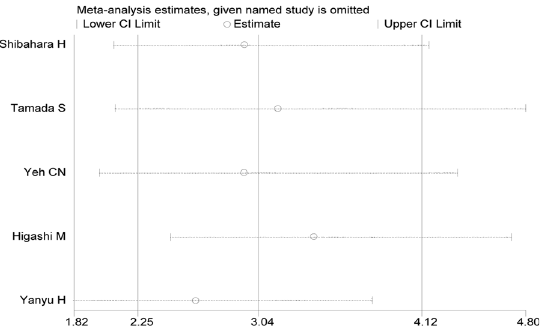
Fig 3. Result of sensitivity analysis. The middle vertical line indicates the combined HR, and the two vertical lines represent the corresponding 95% CI values. The middle small circle and two ends of the dotted lines indicate the pooled HR and 95% CI values, respectively, when the study on the left was omitted after each round of analysis.